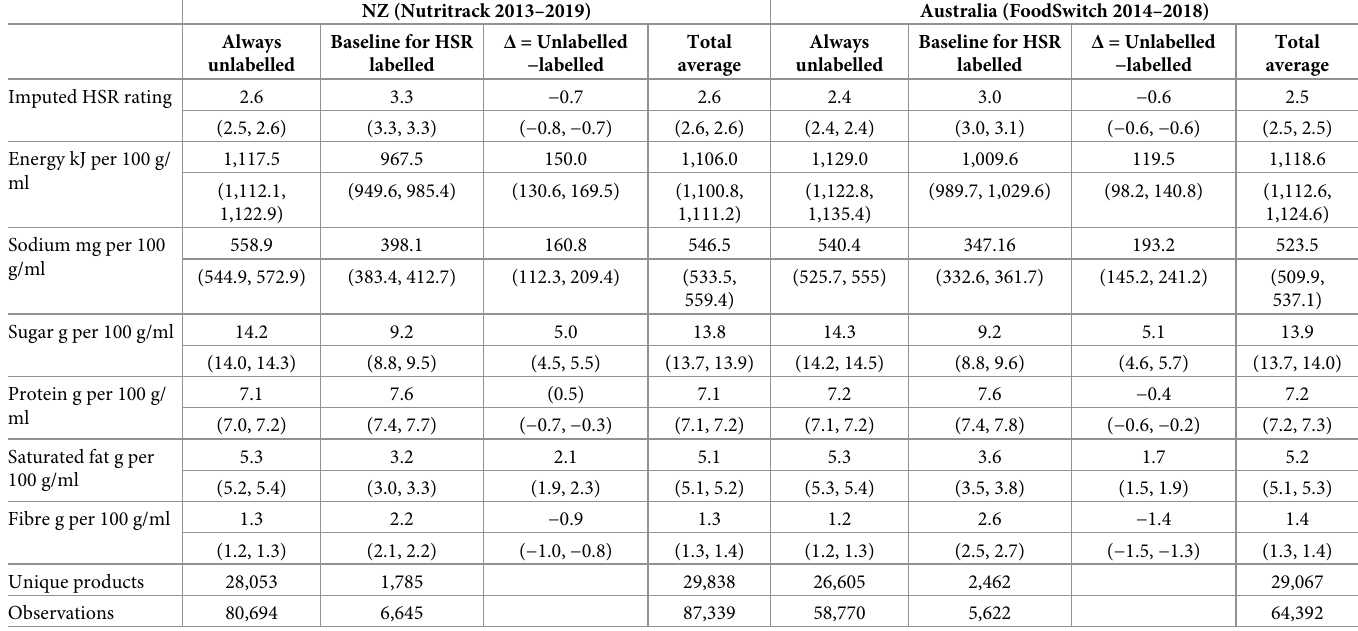
Table 1. Baseline product nutritional composition for the products that never adopted HSR (comparison group) and for those that did (treatment group) over the study